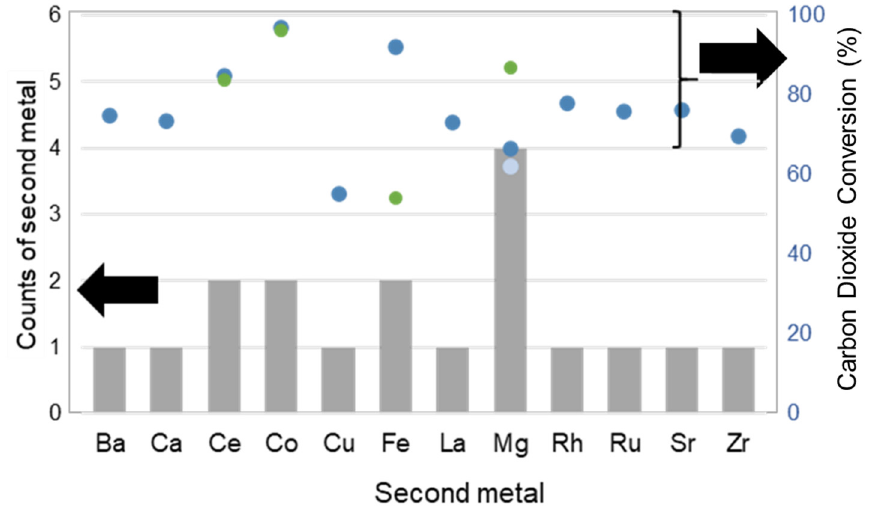
Figure 5. Literature survey plot for second metal and their CO 2 Conversion.